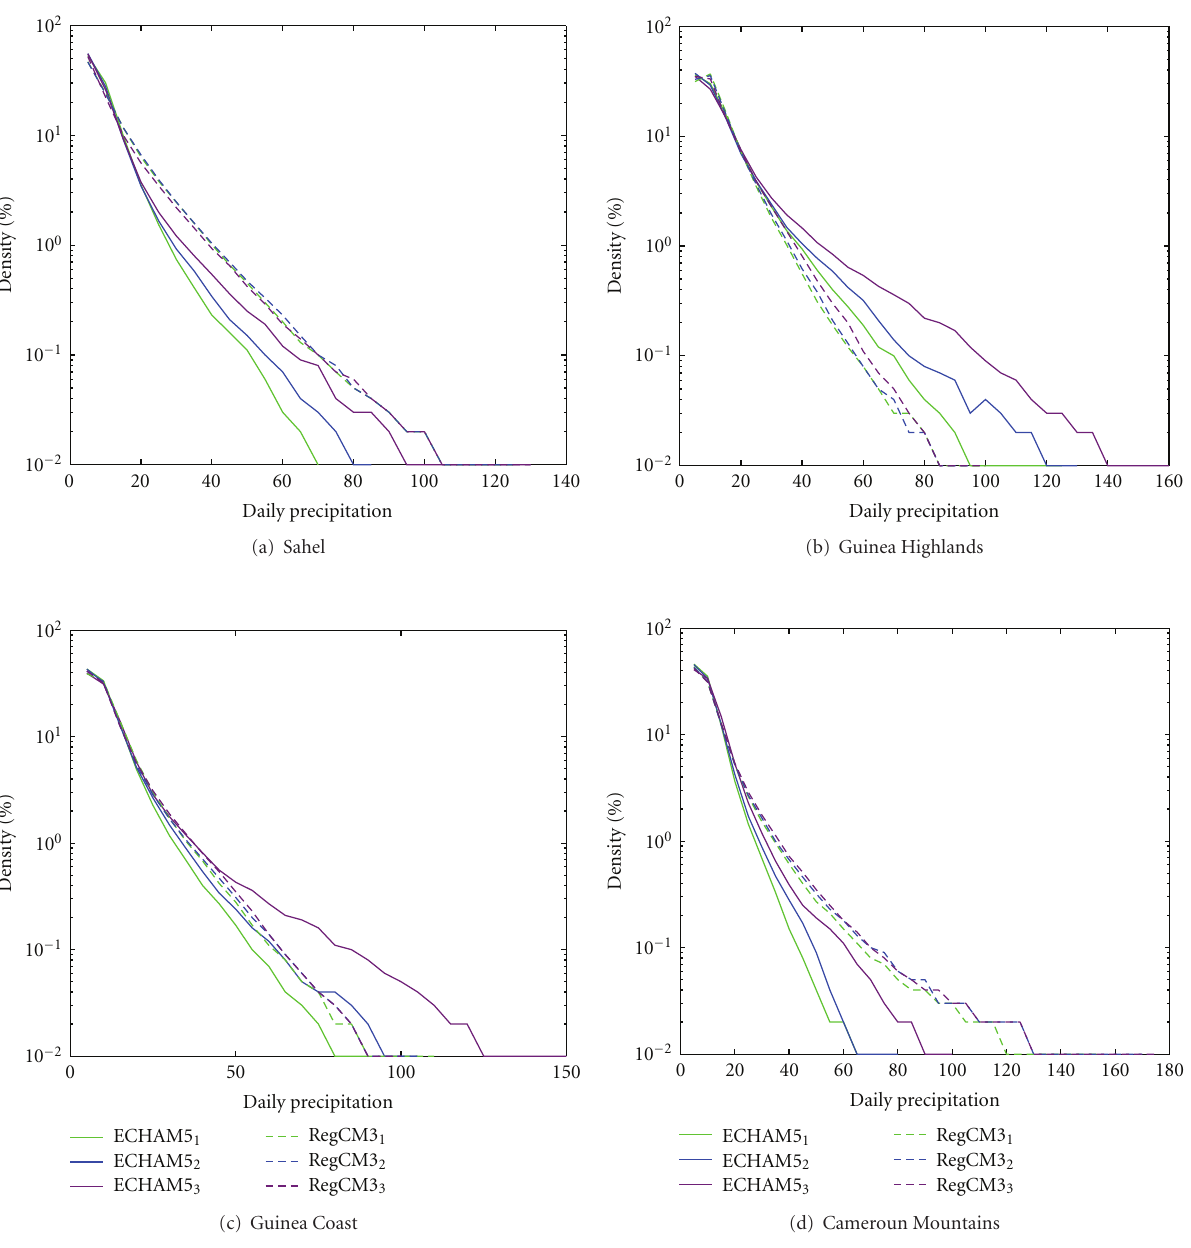
Figure 10: Probability density functions of daily rainfall over (a) the Sahel, (b) the Guinea Highlands, (c) the low elevation terrains of Gulf of Guinea, and (d) the Cameroun Mountains from ECHAM5 (solid lines) and RegCM3 (dashed lines) during the summer season (June–August) of the present day (green lines), the early (blue lines), and the late (violet lines) 21st century.